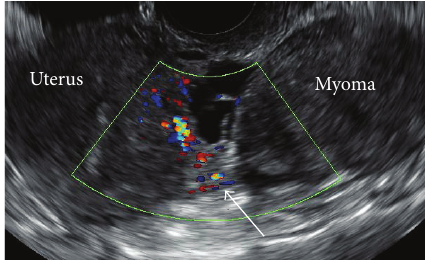
Figure 1: Transvaginal color Doppler ultrasonography showing a pedunculated myoma connected to the uterine body. The blood flow wasinterruptedatthebaseofthemyomapedicle(arrow),suggesting the occurrence of torsion.